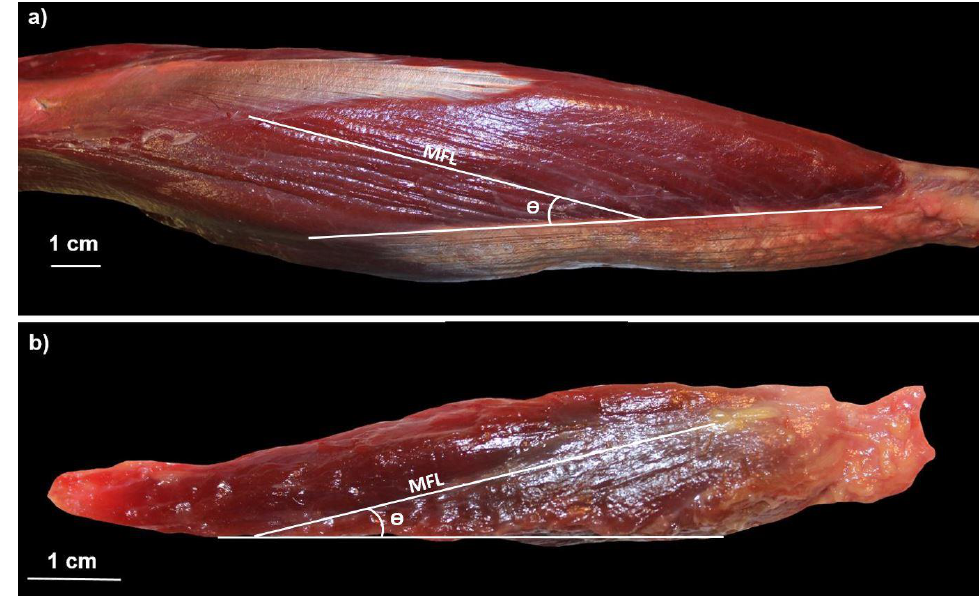
Figure 2. View of the ( a ) triceps brachii and ( b ) anconeus of Pan troglodytes displaying the architectural arrangement of their muscle fascicles. MFL = muscle fascicle length; θ = pennation angle.